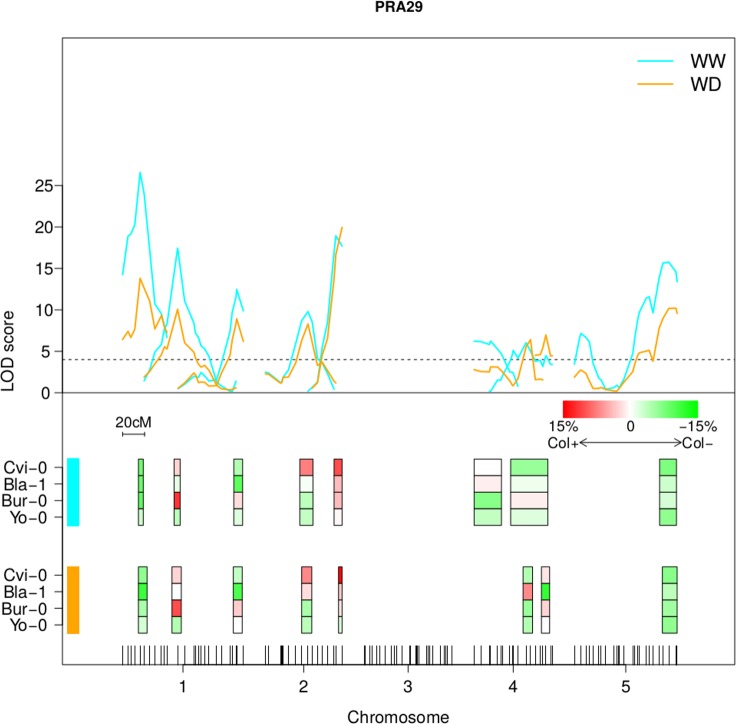
Multi-cross QTL analysis for PRA29.The upper panel of the figure represents the LOD scores calculated by the MCQTL method along the genetic map in WW (blue) and WD (orange) conditions. Each QTL is depicted by a LOD score profile which peak is represented by colored boxes on the lower panel of the figure (WW conditions above and WD conditions below). The color of the box indicates the deviation of the trait value for the Cvi, Bla, Bur or Yo alleles relative to the Col allele as indicated. Chromosome 3 shows no significant combined QTLs for PRA29. This figure shows results obtained for trait PRA29 only; other traits are in S4 and S5 Figs.